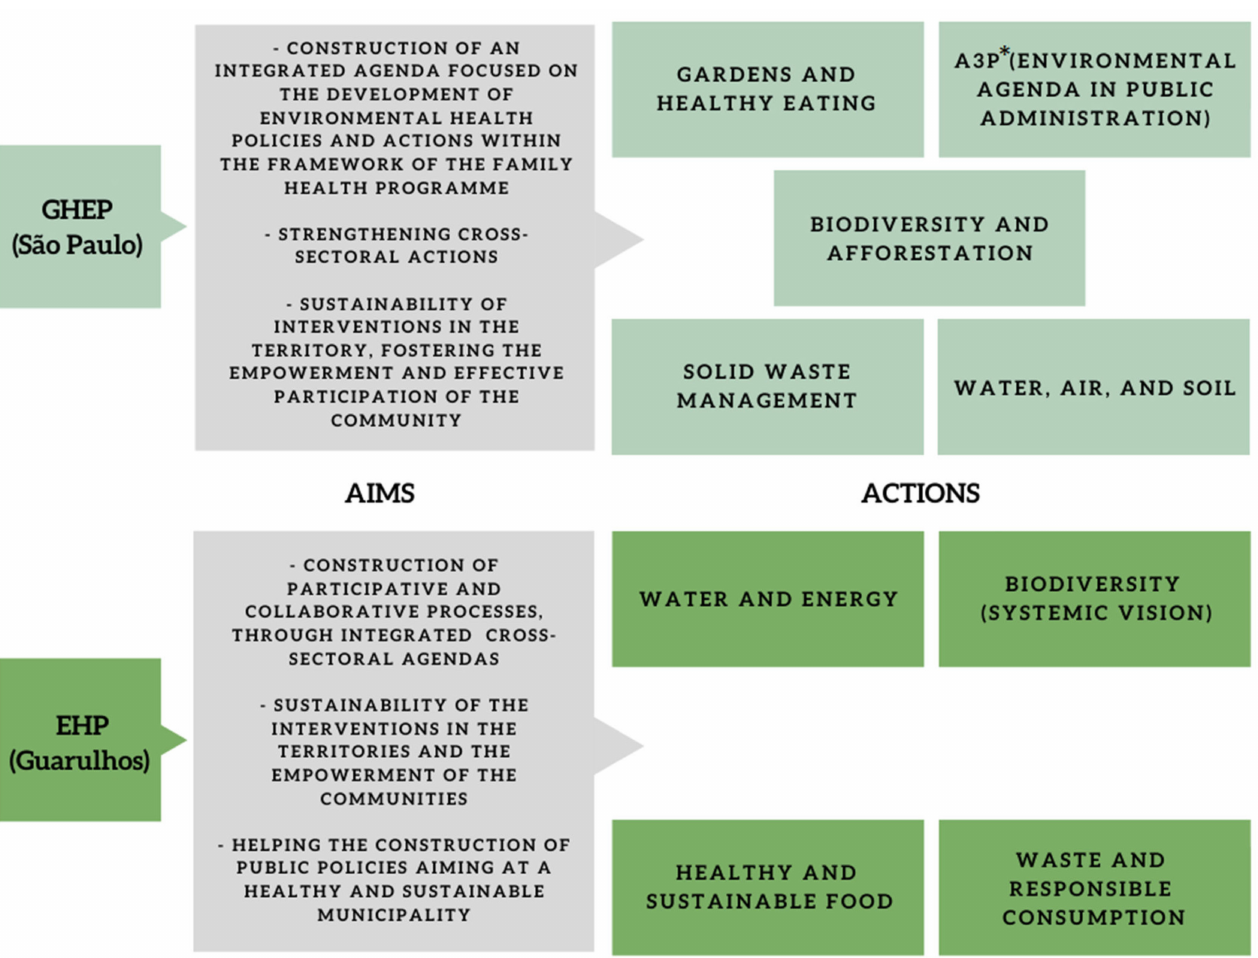
Figure 4. Axes are closely linked to the nexus approach in the municipal programs. *A3P is a program from the Brazilian Ministry of Environment that stimulates public institutions of different levels to implement sustainability practices. Source: Authors’ elaboration based on